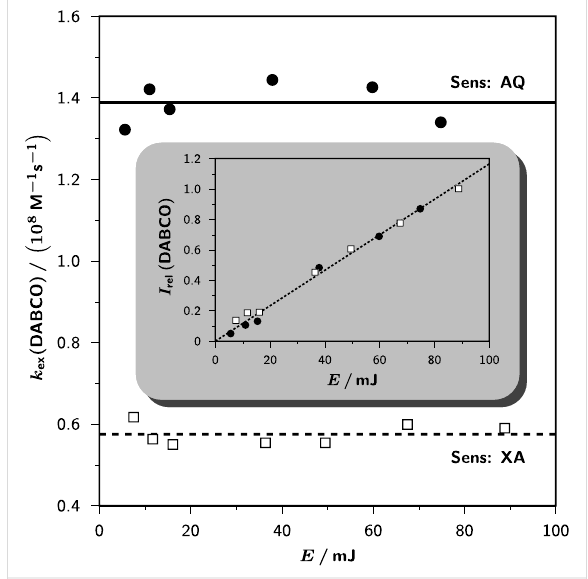
Figure 2: Influence of the laser intensity E on the observed exchange- rate constant k ex (DABCO) (main plot) and on the relative CIDNP intensity I rel (DABCO) of the amine protons, i.e., on the radical concen- tration, (inset) for the two sensitizers anthraquinone (AQ) and xanthone (XA). All other experimental parameters as in Figure 1. For further explanation, see